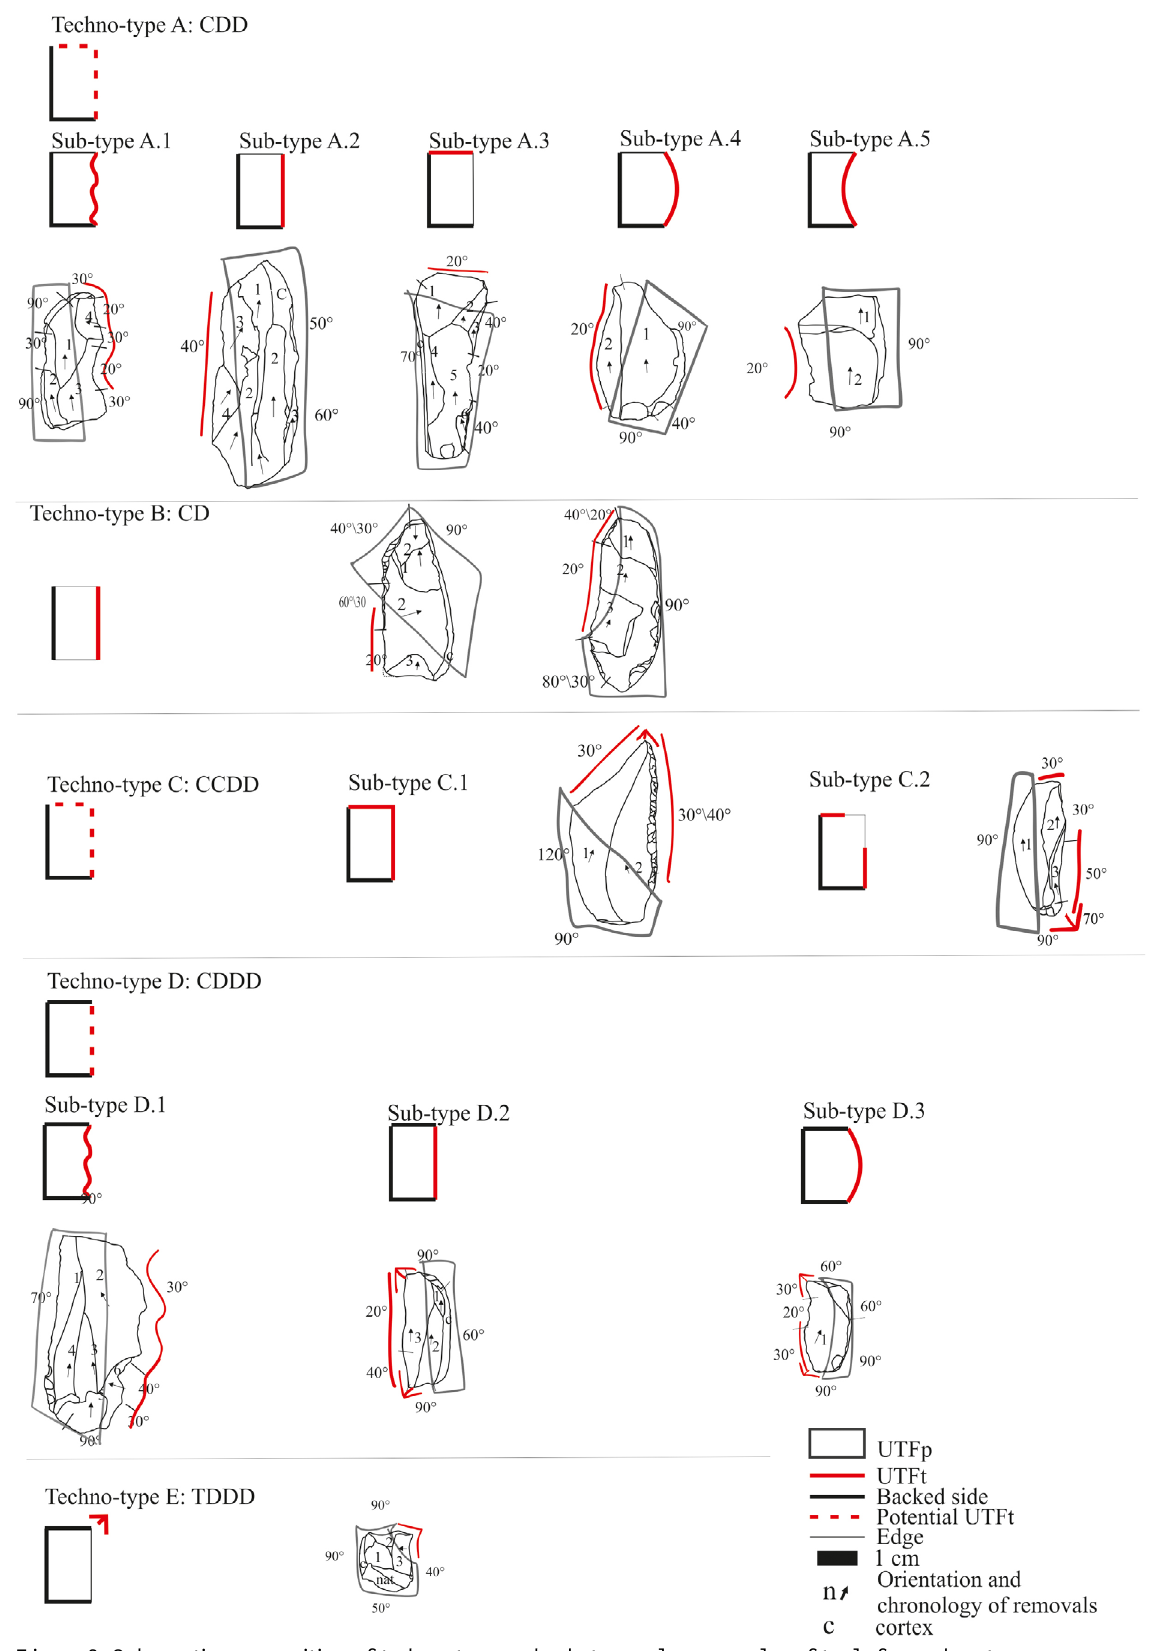
Figure 8. Schematic composition of techno-type and sub-type, plus examples of tools for each